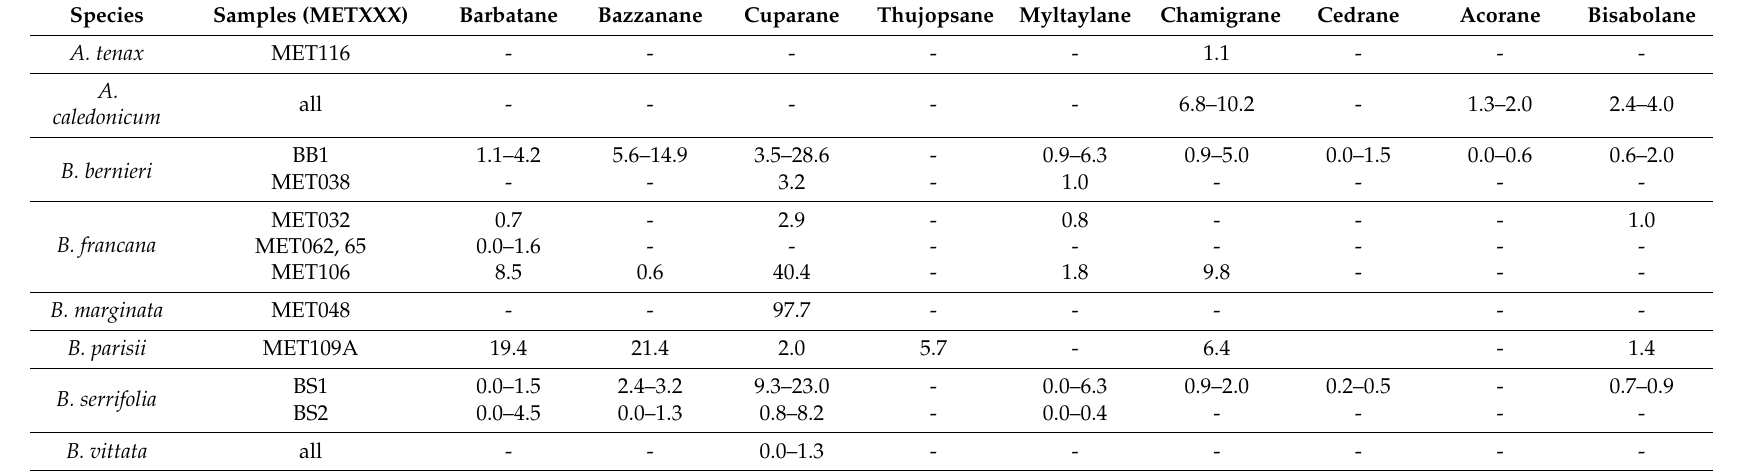
Table 5. Distribution of detected sesquiterpene types affiliated with the bisaboyl cation (relative percentage,